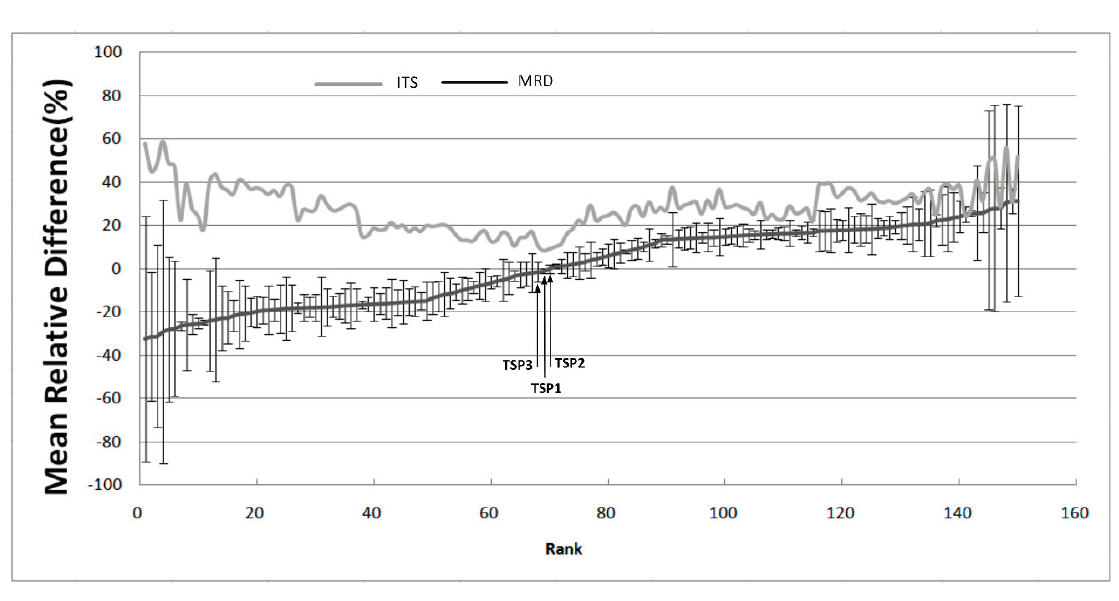
Figure 6. Rank-ordered MRD of the volumetric soil moisture and ITS for 150 points in the study area from 2003 to 2013. The vertical bars correspond to the associated MRD standard deviations. The light grey curve indicates the ITS, and the labeled points have the minimum ITSs.